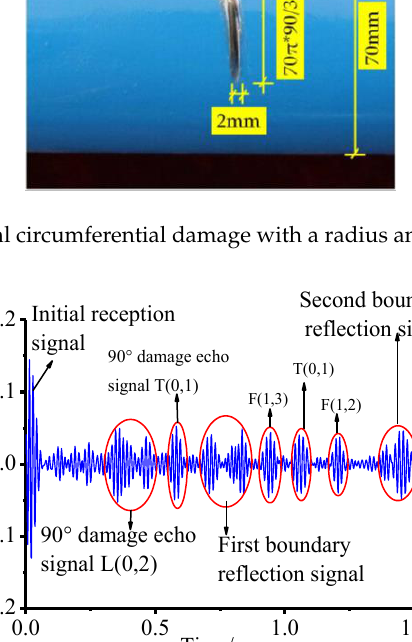
Figure 26. The schematic of the mode conversion signal propagating in the pipe in the experiment. It is also found that the amplitude of the damage echo signal is obviously greater than that for the 45° damage because of the more obvious reflection effect. But the amplitude of the boundary